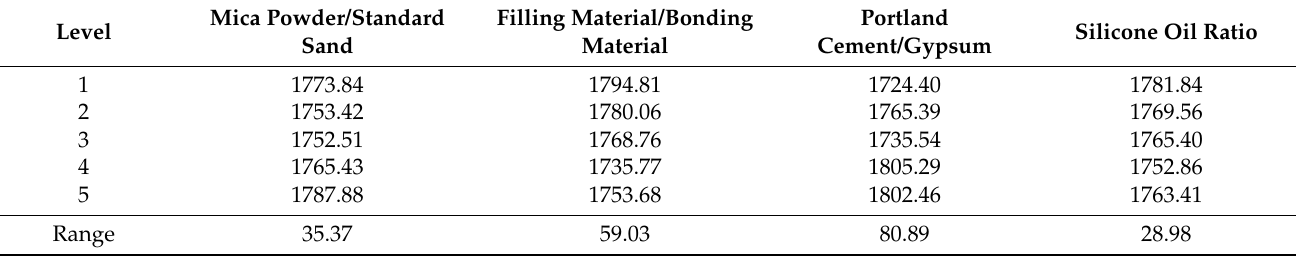
Table 5. Range analysis of density kg/m 3